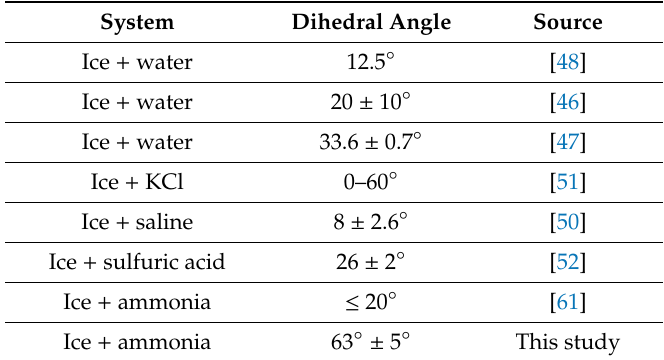
Table 3. Reported dihedral angles for several ice binary